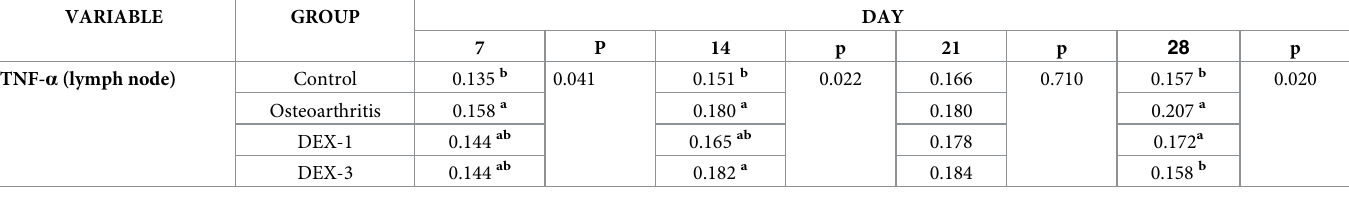
Table 4. Assessment of TNF- α levels in lymph node supernatants by means of the Kruskal-Wallis and Dunn’s tests.